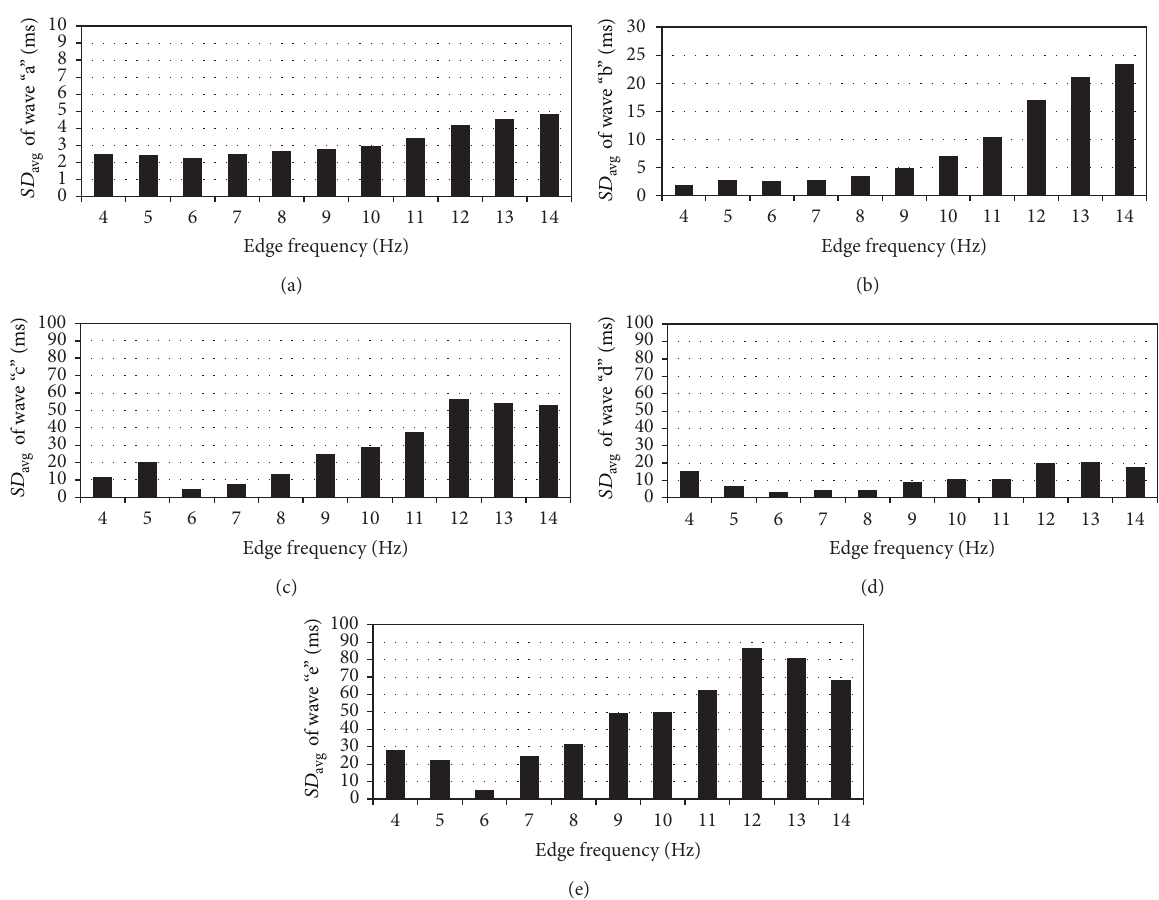
Figure 6: The average standard deviations ( 𝑆𝐷 ) of the waves “a”, “b”, “c”, “d”, and “e” on the time domain at different edge frequencies avg for 21 healthy subjects. (a) standard deviation of wave “a” at different edge frequencies; (b) standard deviation of wave “b” at different edge frequencies; (c) standard deviation of wave “c” at different edge frequencies; (d) standard deviation of wave “d” at different edge frequencies; (e) standard deviation of wave “e” at different edge frequencies.